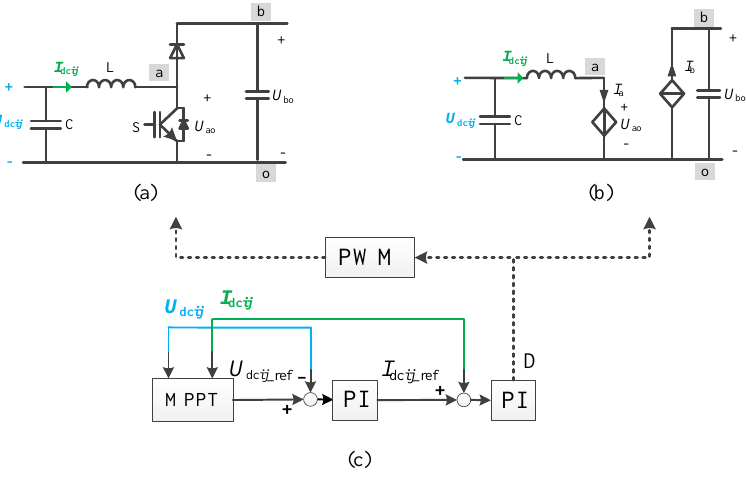
Figure 3. ( a ) Boost converter topology; ( b ) Average model of boost converter; and, ( c ) Controller design of boost